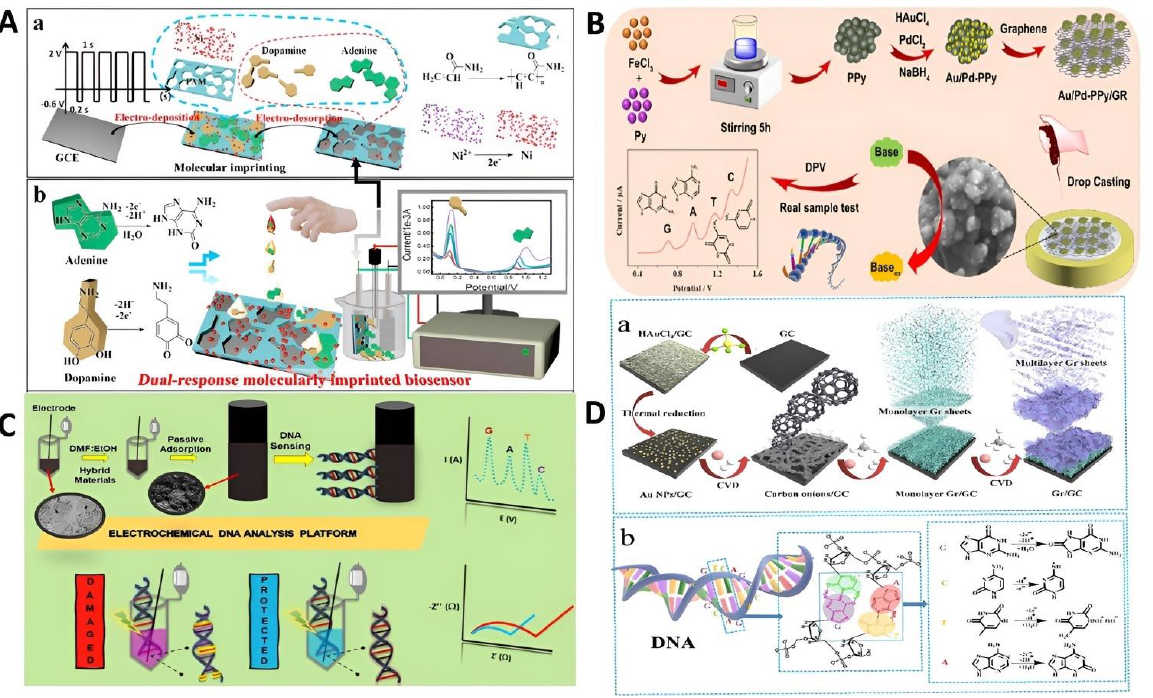
Figure 5. ( A ) Assembly technique of the dual-response MIP detection membrane for A and DA, ( a ) and ( b ) A and DA EC detection mechanisms. Reprinted with permission from [167]. ( B )